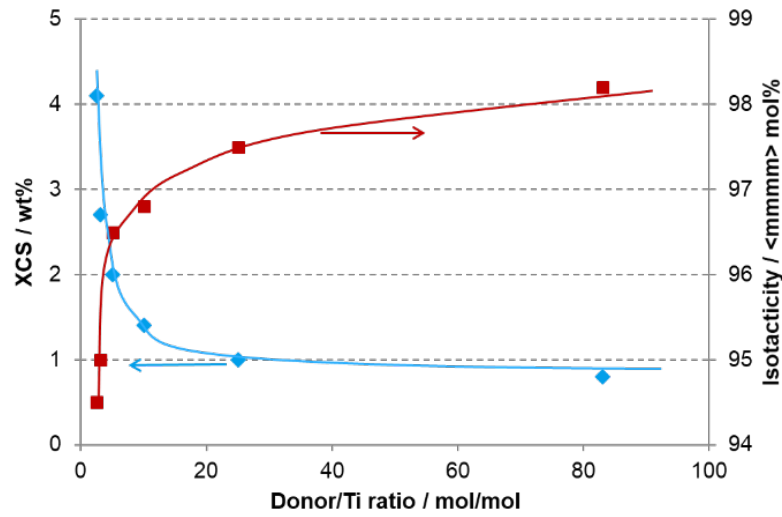
Figure 6. Effect of the molar ratio between donor and Ti on isotacticity (red, pentad regularity by 13 C-NMR) and xylene cold soluble (blue, XCS) fraction (data from [38]).